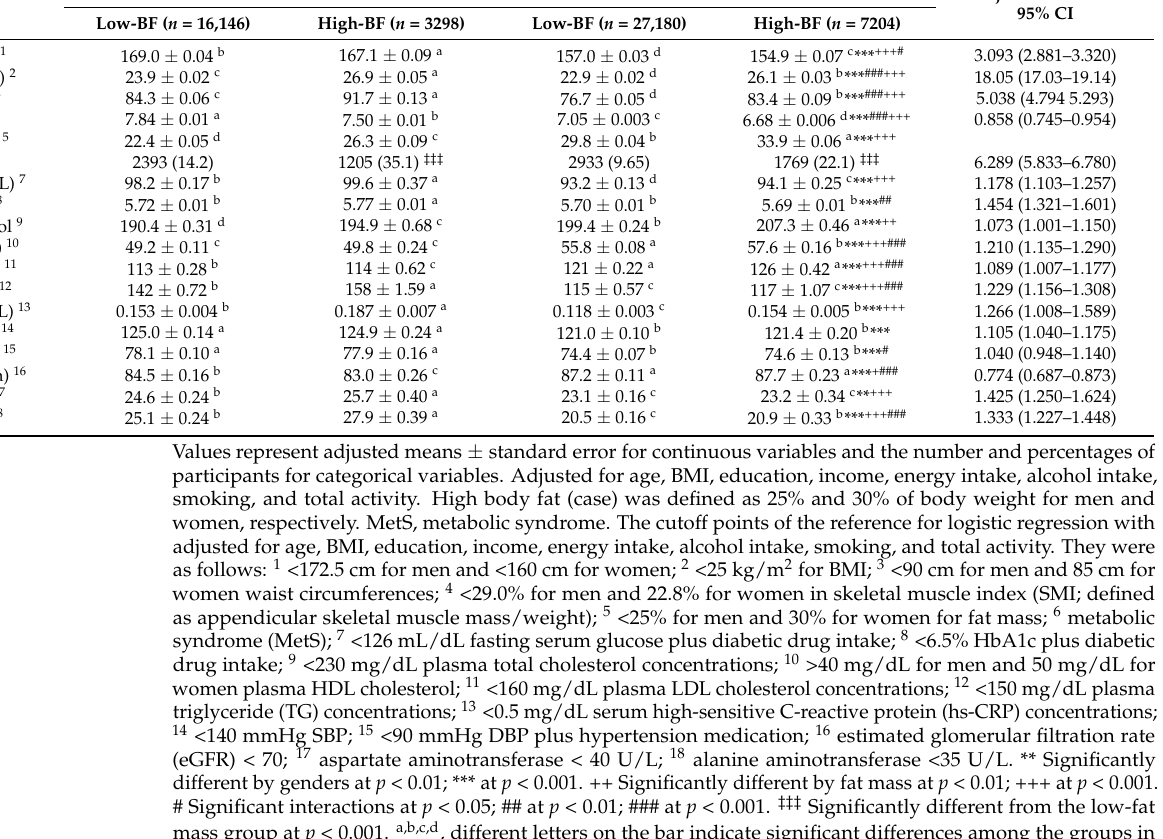
Table 3. Adjusted means and association of anthropometric and biochemical variables in the urban- hospital-based cohort according to genders and body fat mass (BF).